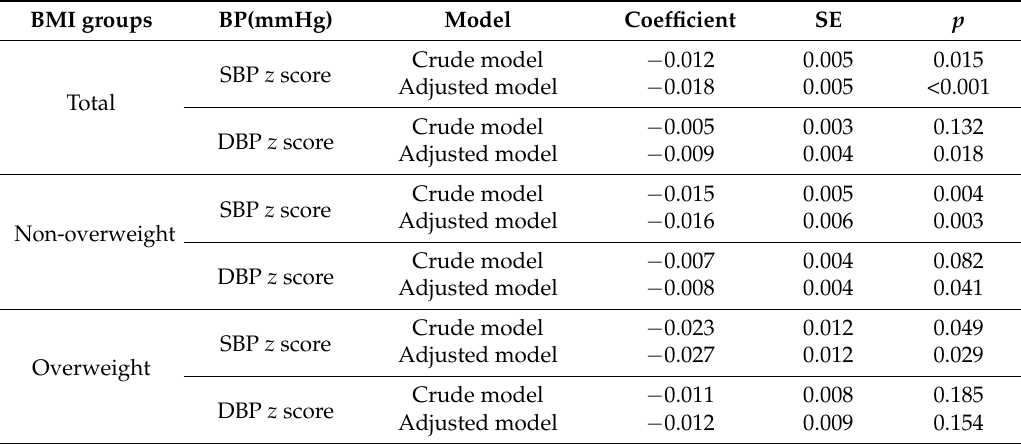
Table 2. Association between vegetable consumption and BP z score among 13–17-year-old adolescents, stratified by BMI.